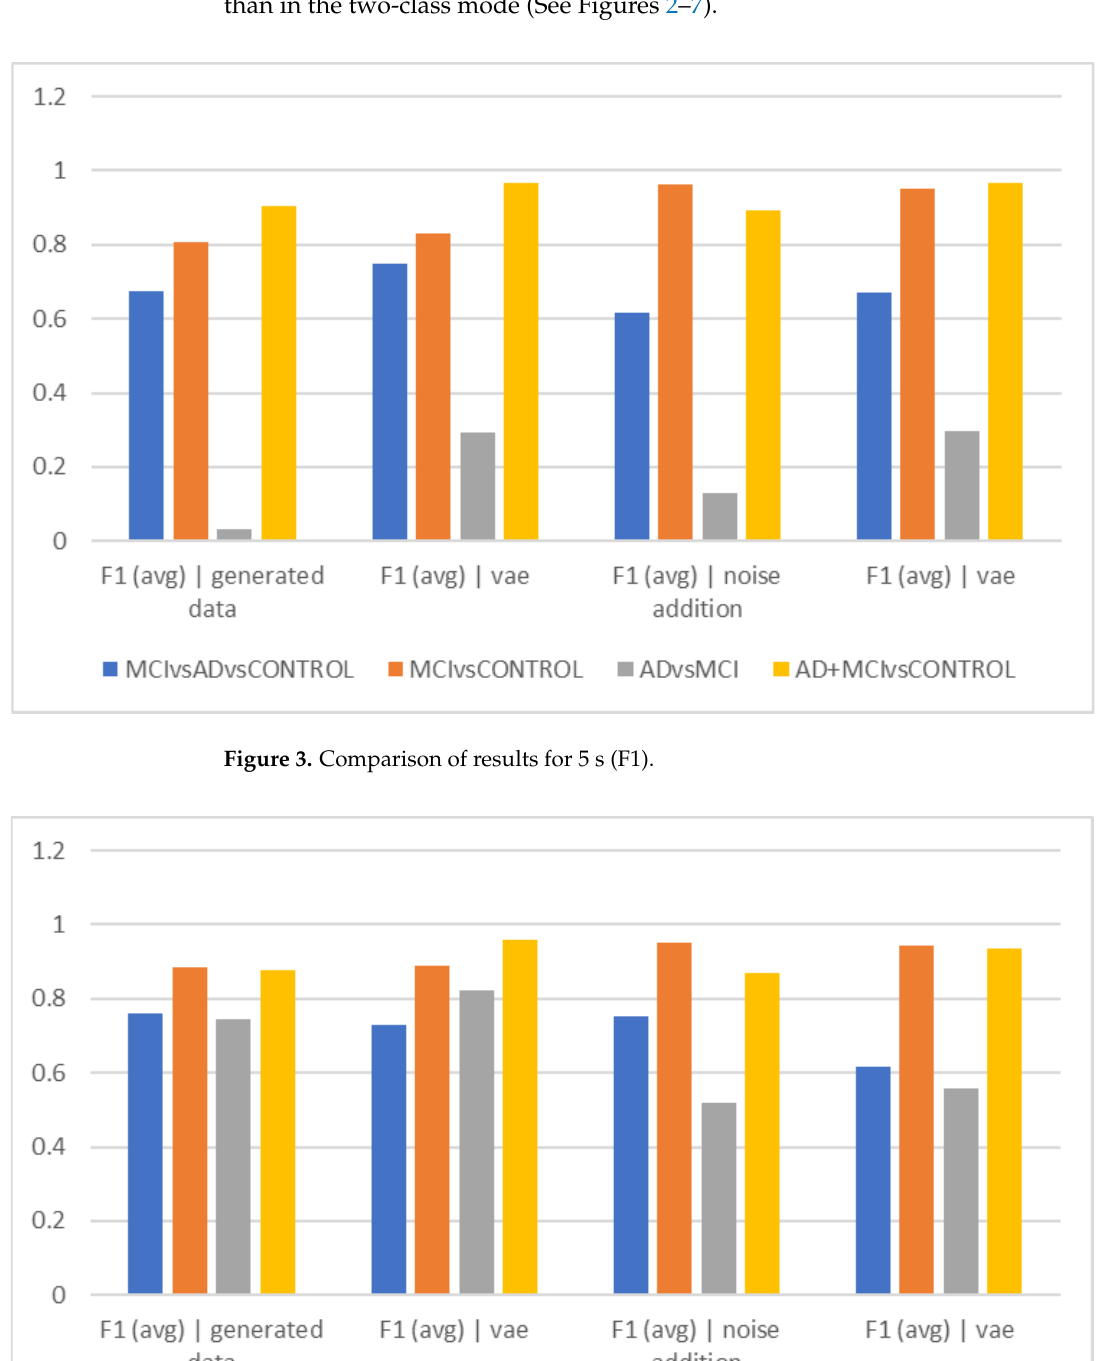
Figure 2. Comparison of results for a period of 5 s (accuracy).